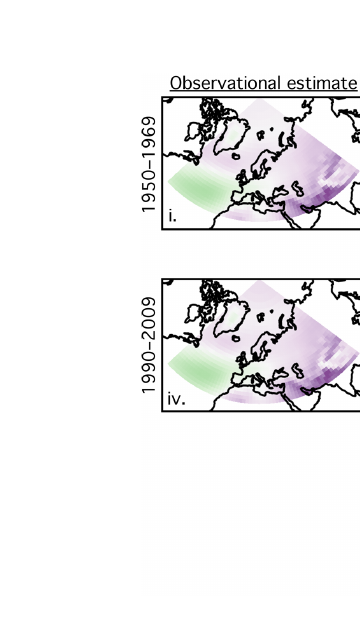
Figure C3. The spatial pattern of DJF SLP climatology for 1950–1969 (i–iii), 1990–2009 (iv–vi), and 2080–2099 (vii–viii). The ERA-20C observational estimate of SLP climatology is shown in i and iv. The ensemble member with the lowest domain-average SLP climatology for the 1990–2009 historical period is shown in ii, v, and vii. The ensemble member with the highest domain-average SLP climatology for the 1990–2009 period is shown in iii, vi, and viii.